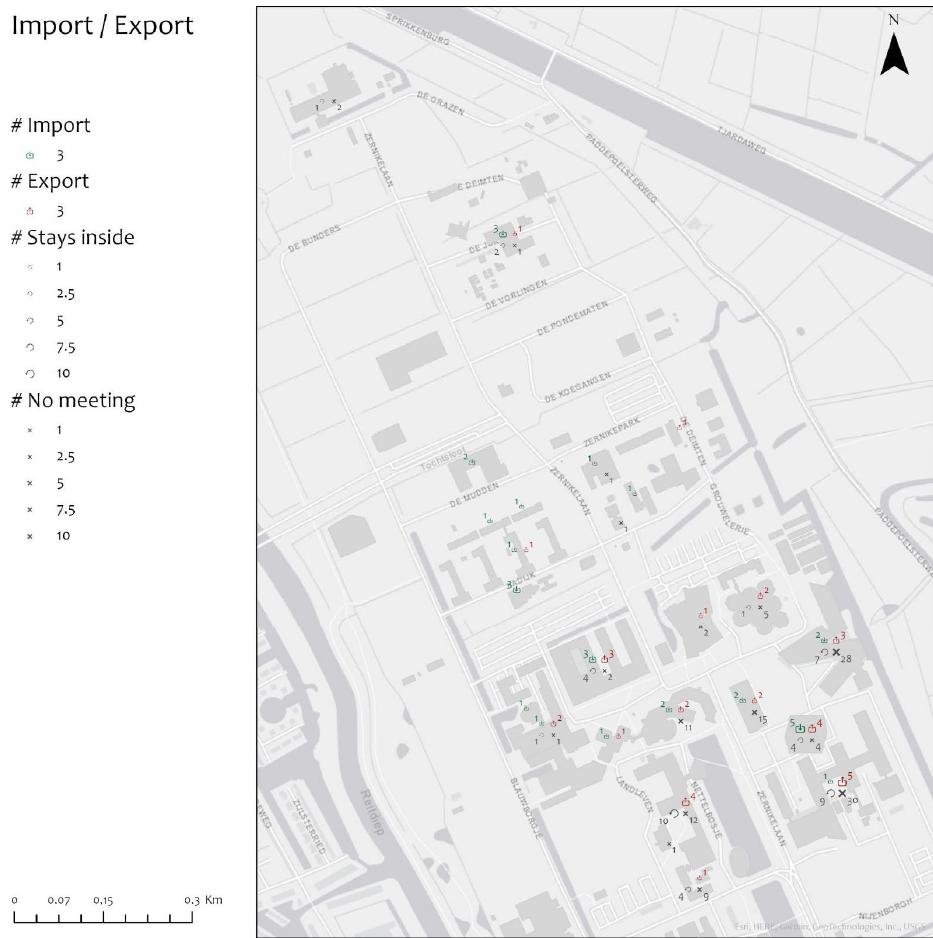
Figure A8. RUG campus—import/export of unplanned meetings with companies. # = ‘Number of’.